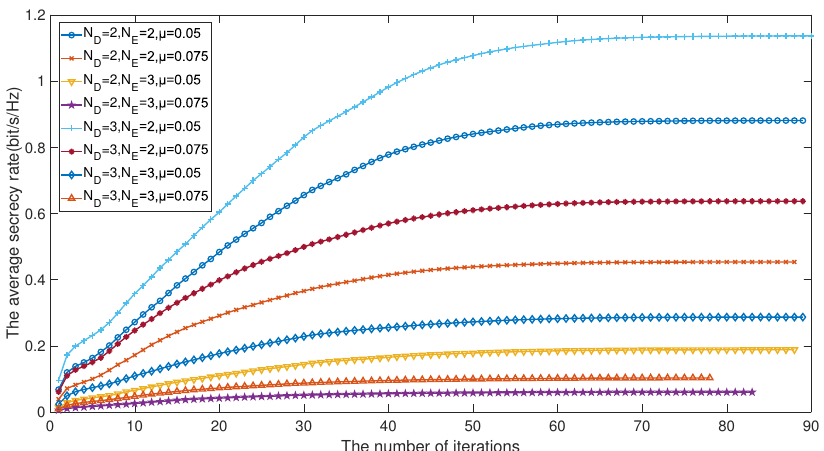
Figure 2. Average secrecy rate versus the number of iterations, a comparison of different ports number and CSI uncertainty.